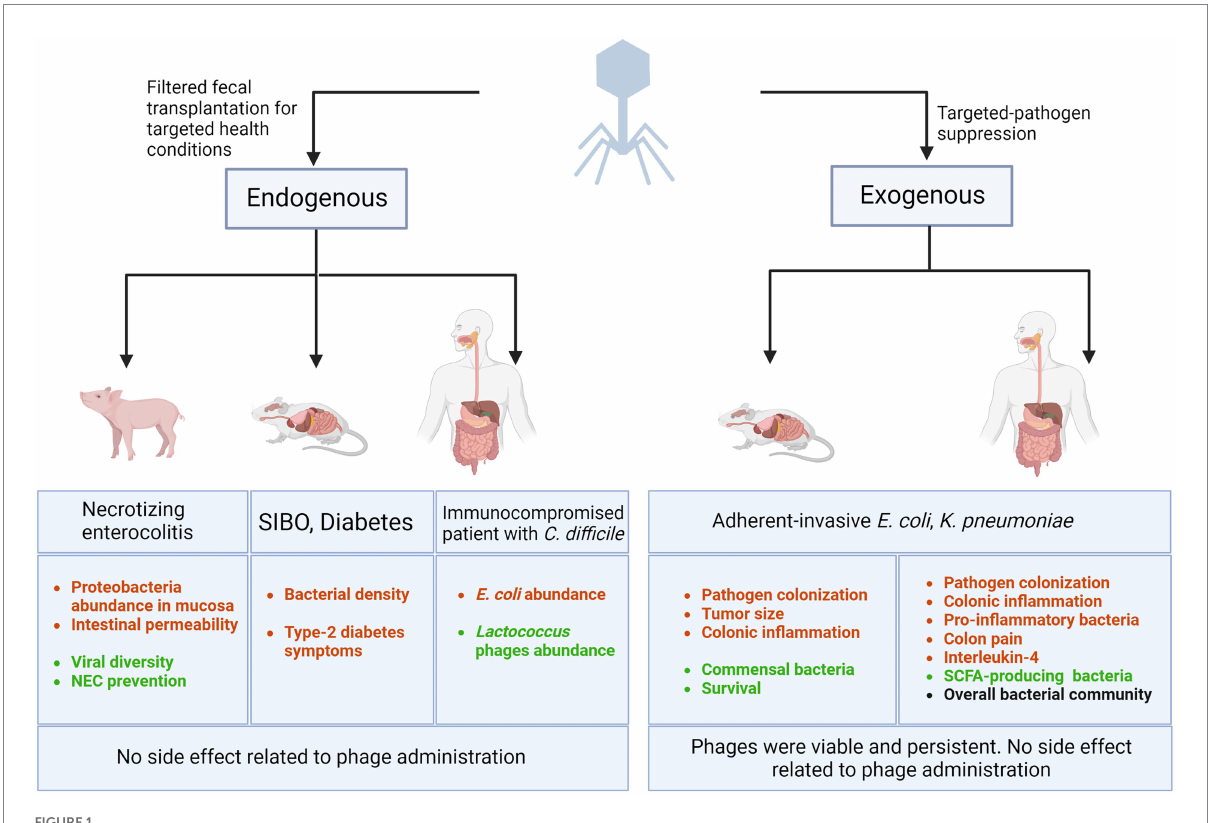
FIGURE 1 Bacteriophage-related interventions in GI diseases. Lytic phages are being used (1) as the components of filtered fecal matter transplanted in animals and humans (or endogenous phages) to combat health conditions such as necrotizing enterocolitis, Small intestinal bacterial overgrowth (SIBO), diabetes, and recurrent C. difficile colonization, (2) as targeted-pathogen suppressor (or exogenous phages) by administering specific phages to animal models or humans to eradicate a selective bacterial pathogen and improve symptoms, survival, and patient outcomes. Decreased outcomes are represented in red and improved outcomes are shown in green. Black text represents consistent and stable outcome. Created with